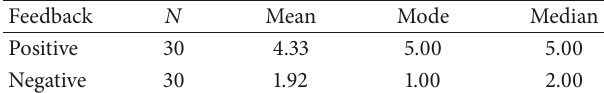
Table 6: Positive and negative